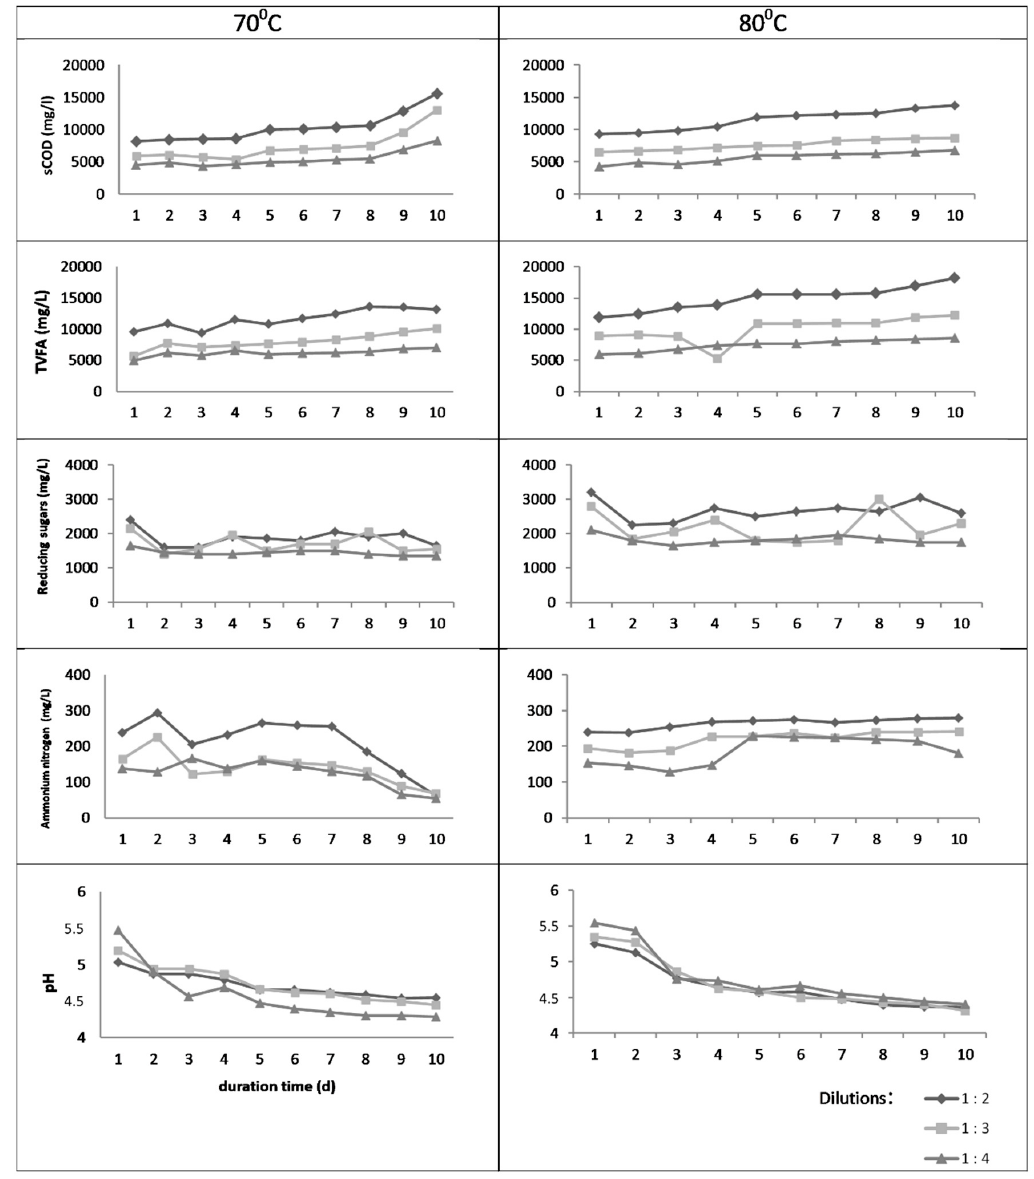
Figure 3. Evolution of sCOD, TVFA, reducing sugars, ammonium nitrogen and pH during hyperthermophilic treatment of